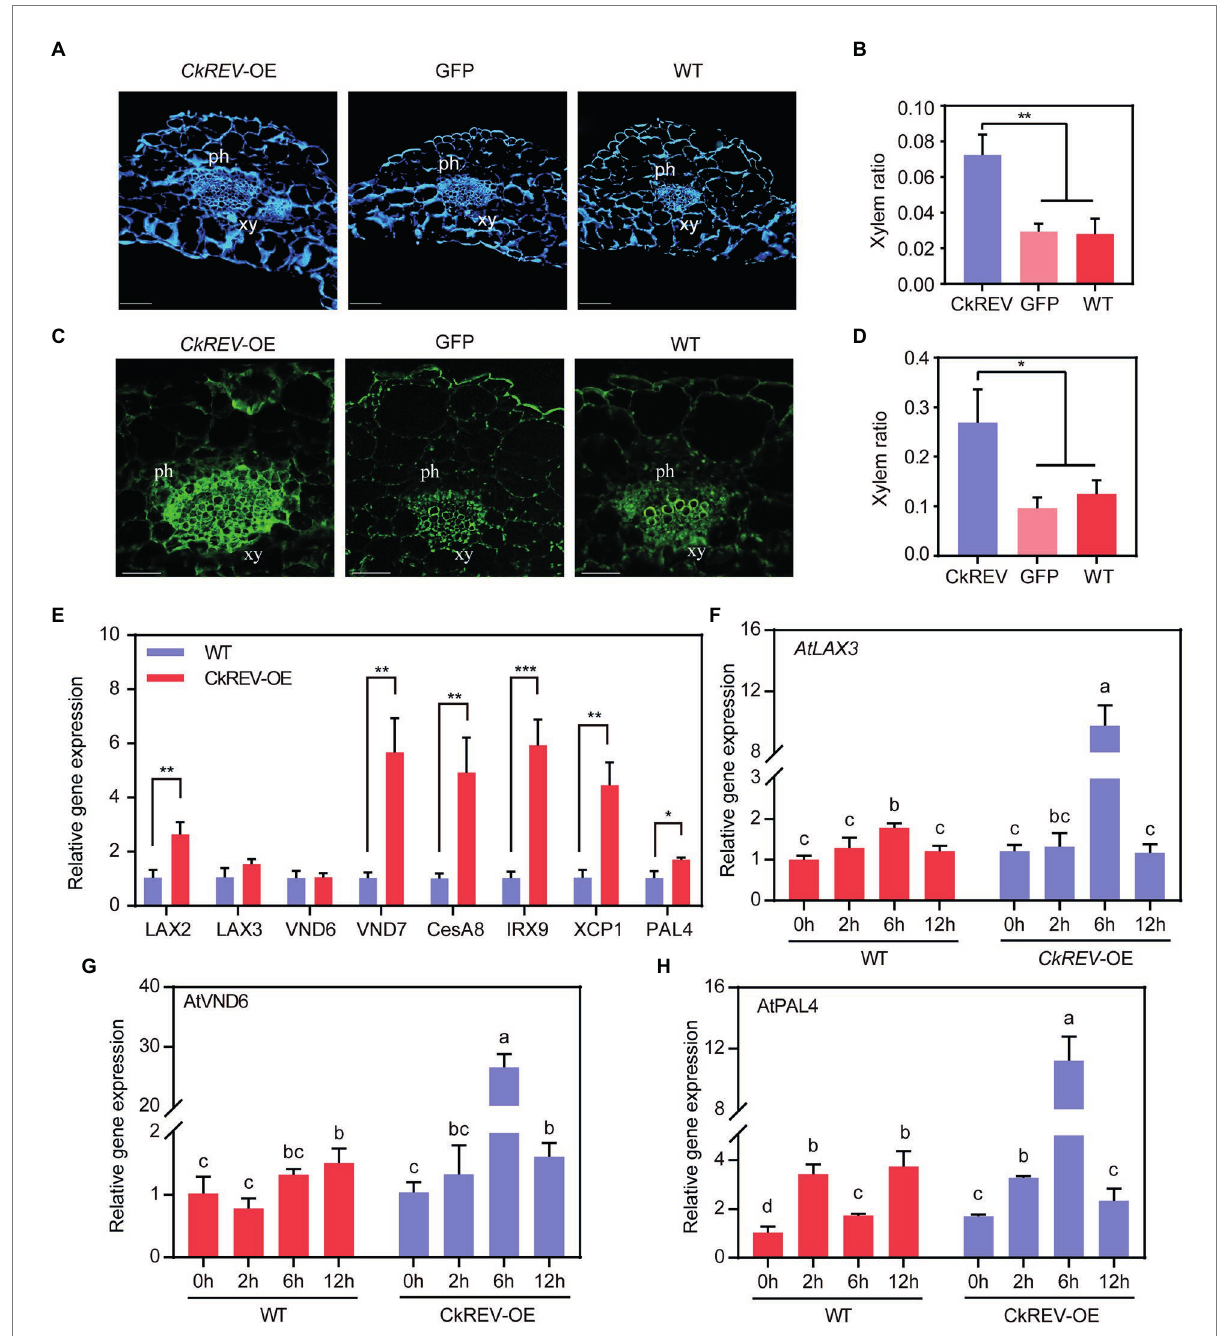
FIGURE 3 CkREV promotes cellulose and lignin deposition in xylem vessels. (A,B) Calcofluor white staining on leaf vein sections of A . thaliana CkREV -OE lines (A) and the ratio of stained xylem region to the entire vascular bundle (B) . ph, phloem; xy, xylem. (C,D) Observation on lignin auto-fluorescence on leaf vein sections of A. thaliana CkREV -OE lines (C) and the ratio of stained xylem region to the entire vascular bundle (D) . ph, phloem; xy, xylem. (E) qRT- PCR analysis on the level of genes concerning polar auxin transport, vessel differentiation, and the synthesis of cellulose, xylan, and lignin in A. thaliana CkREV -OE lines. (F) Expression pattern of AtLAX3 gene detected by qRT-PCR under drought gradient. (G) Expression pattern of AtVND6 gene detected by qRT-PCR under drought gradient. (H) Expression pattern of AtPAL4 gene detected by qRT-PCR under drought gradient. Error bars indicate SD ( n = 3). (B,D,E) Student’s t -test is employed to measure statistical significance between two samples with confidence level at 0.95 (* p < 0.05; ** p < 0.01; and *** p < 0.001). (F–H) One-way ANOVA is performed for the statistical analysis, where different letters represent significant differences ( p < 0.05).